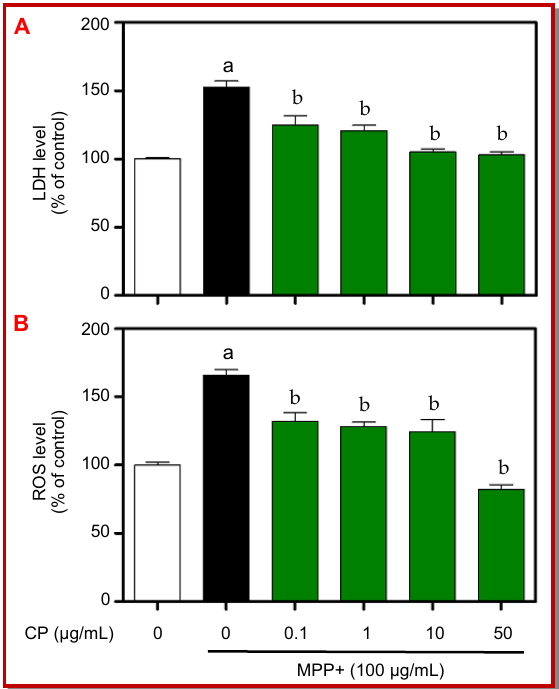
Figure 1: Effects of Cicadidae Periostracum (CP) on cytotoxicity and reactive oxygen species (ROS) levels. (A) Effects of CP on 1- methyl-4-phenylpyridinium (MPP+)-mediated toxicity to differ- entiated PC12 cells. (B) ROS levels were measured using the 2,7- dichlorofluorescin diacetate assay. Values are presented as means ± S.E.M. a p<0.001 compared with the control group;